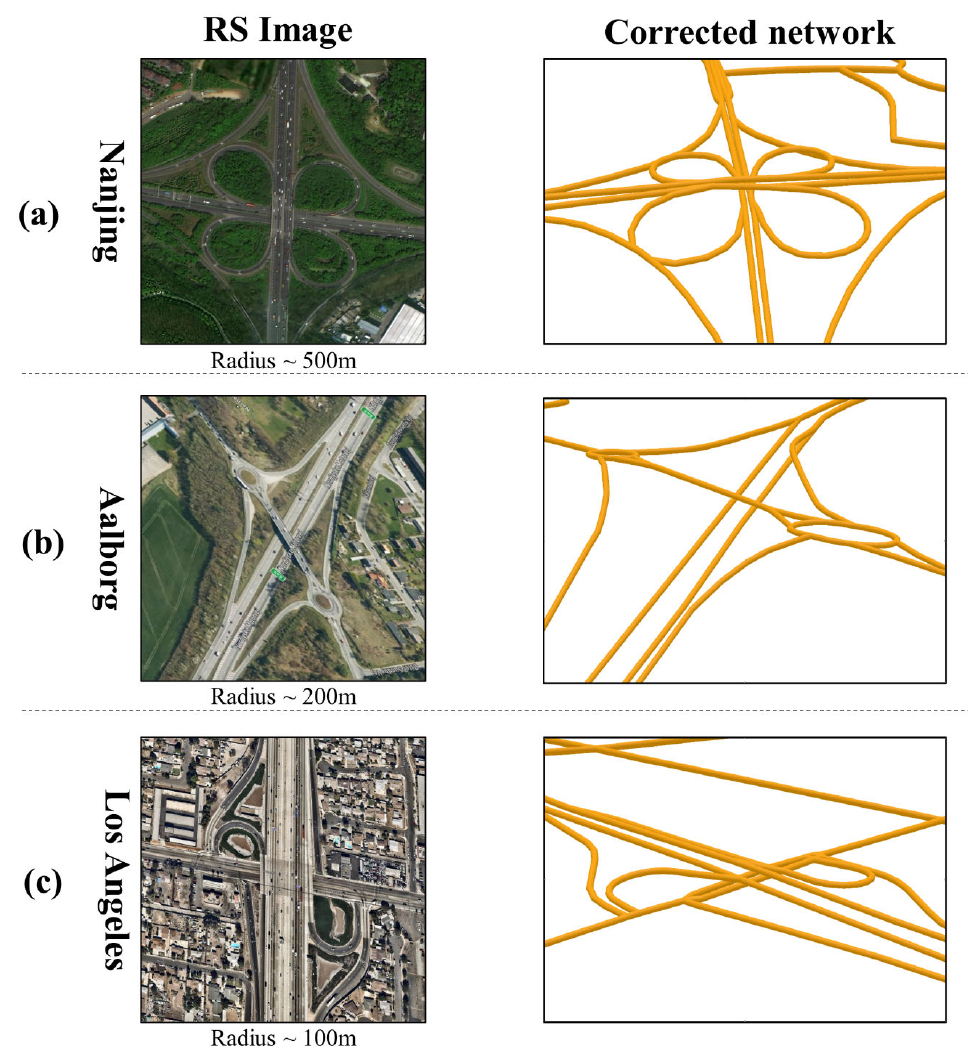
Figure 8. Road Topology validation with RS images in three interchanges of different radii. ( a ) Nanjing, radius about 500 m; ( b ) North Jutland, radius about 200 m; ( c ) Los Angeles, radius about 100 m.